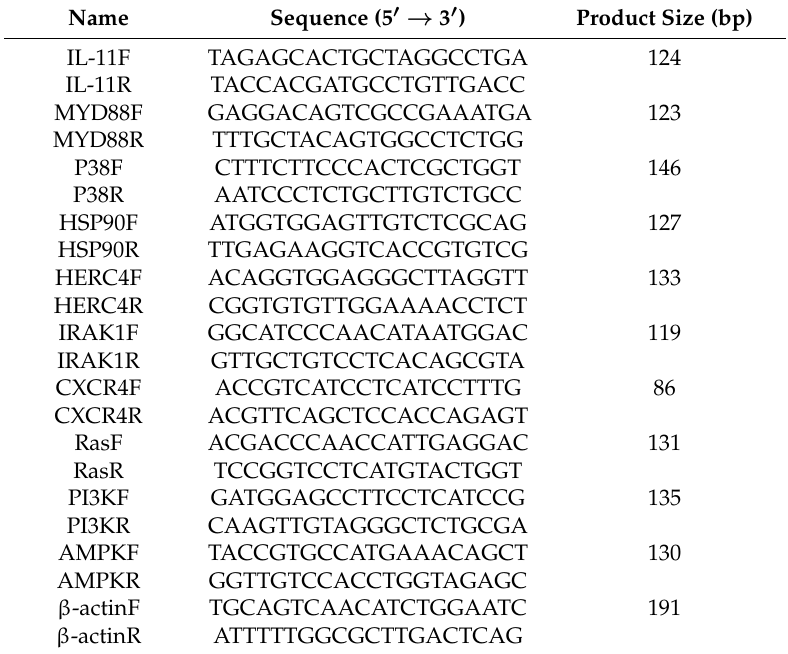
Table 1. Primers, sequences, target genes, product sizes, and applications used in the present